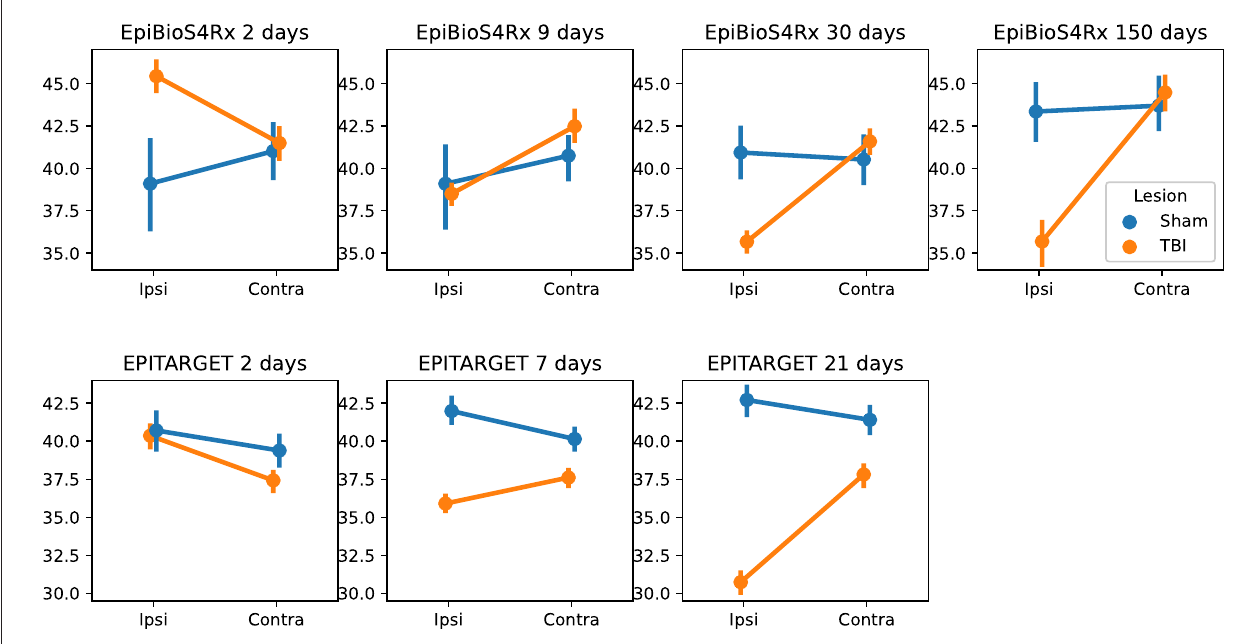
FIGURE 9 | Comparison between the hippocampal volumes (mm 3 ) for each dataset and time point between sham and TBI animals. Note the different dynamics in ipsilateral hippocampal volume changes between the EpiBioS4Rx and EPITARGET animals, particularly at 2 days post-injury. The rats in the EpiBioS4Rx cohort were anesthetized with 4% isoflurane at the time of injury. The rats in the EPITARGET cohort were anesthetized with pentobarbital-based anesthesia cocktail, which apparently reduced the acute post-impact seizure-related swelling better than